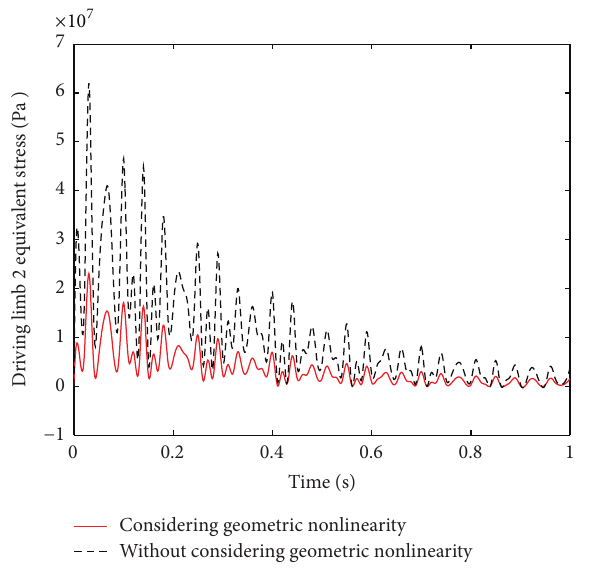
Figure 10: Equivalent stress of driving limb 4.